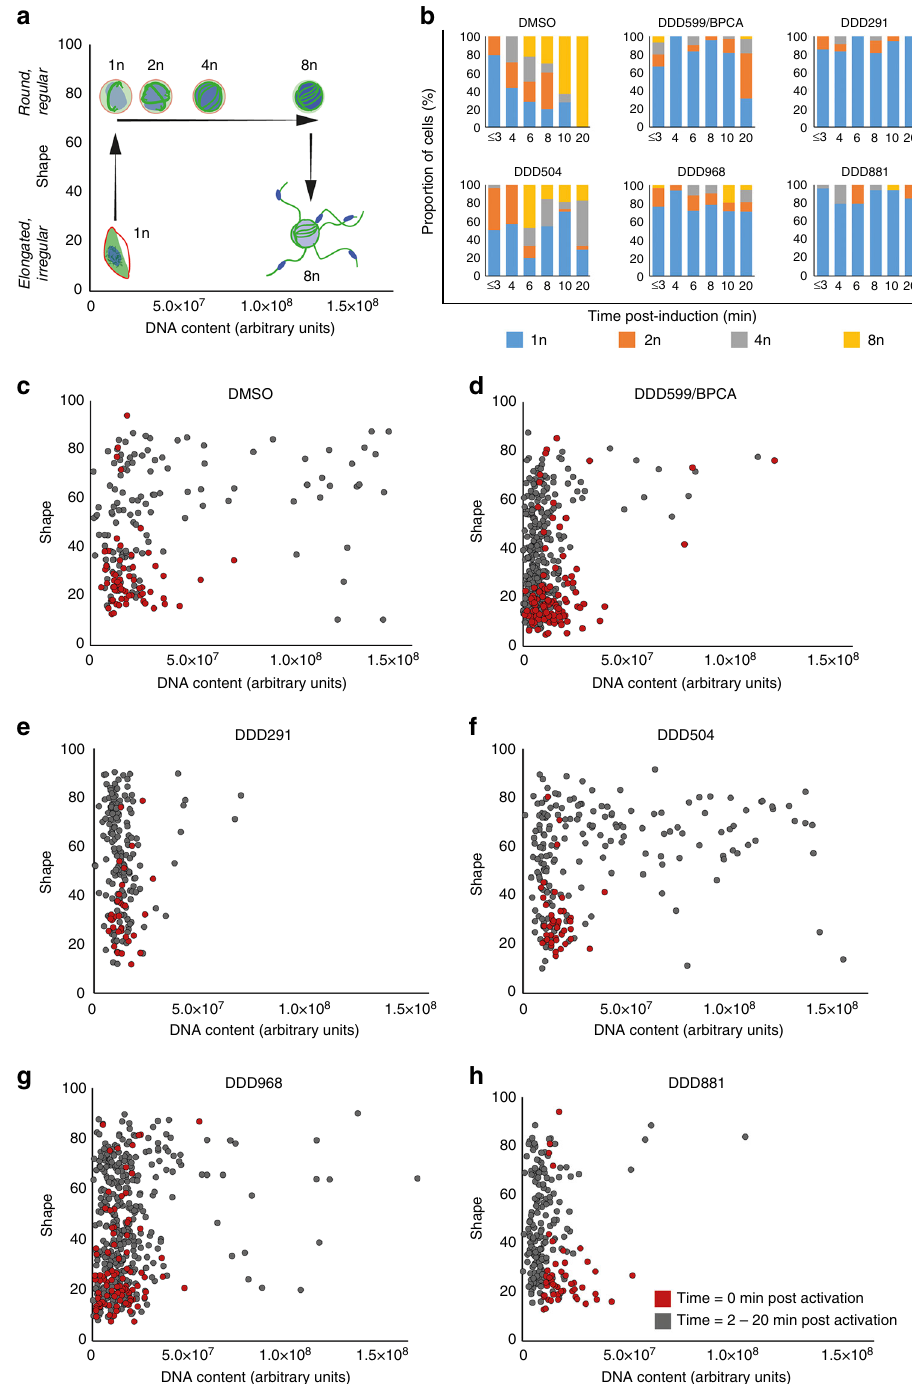
Fig. 5 Computer-aided quanti fi cation of male gamete formation from IFA images. Individual cells were extracted from IFA images stained for α -tubulin, glycophorin A and DNA from samples fi xed between 0 and 20 min post induction of gamete formation ( n = 195 – 668 cells per compound treatment). Cell shape (elongated/irregular vs. round) and haploid chromosome number (1nto 8n) were estimated from α -tubulin and DAPI staining (DNA content) respectively (arbitrary units). a Schematic diagram illustrating how cell shape and DNA content parameters vary over the course of male gamete formation. Initially gametocytes are elongated with 1n haploid chromosome number. Upon induction, they round up then undergo three rounds of DNA replication whilst maintaining a round shape. Finally, male gamete release (ex fl agellation) changes the shape of the cell whilst maintaining a high DNA content. b Genome copy number during gamete formation was estimated by benchmarking mean DAPI intensity with respect to the non-activated gametocytes at t = 0 min (1n) and ex fl agellating cells at t = 10 – 20 min (8n). DNA replication was compared between the DMSO control and fi ve test compounds. c – h Graphs plotting the cell shape and DAPI intensity data for each individual cell analysed. Red dots show the initial distribution of cells before induction ( t = 0 min). Grey dots show induced cells ( t = 2 – 20